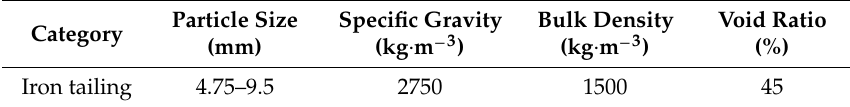
Table 2. Basic properties of the coarse aggregate of iron